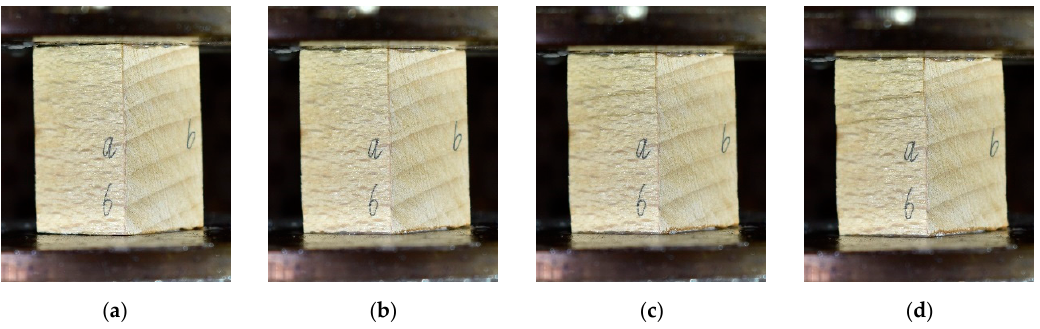
Figure 4. Deformations of beech specimen in QTRD at different times of ( a ) 0 s, ( b ) 6.5 s, ( c ) 12 s, and ( d ) 14 s.